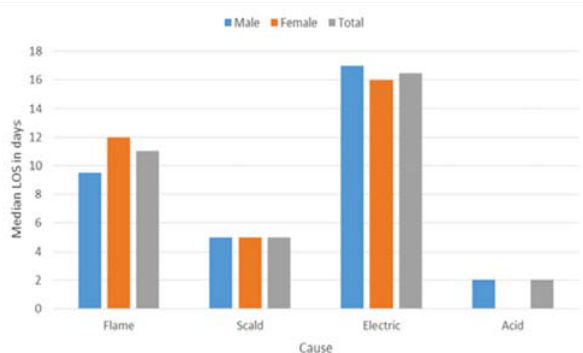
Figure 9. Patient distribution according to median